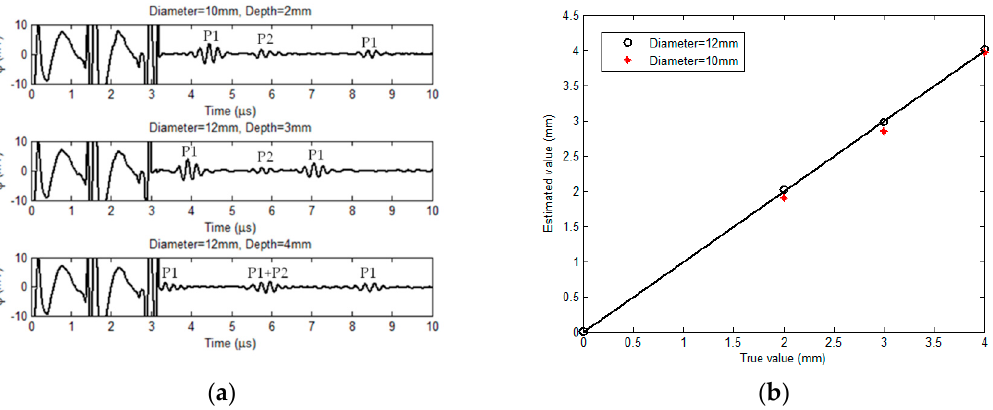
Figure 11. Experimental results: ( a ) Acquired signals vs. corrosion sizes; and ( b ) comparison between the approximated corrosion depths and true values.